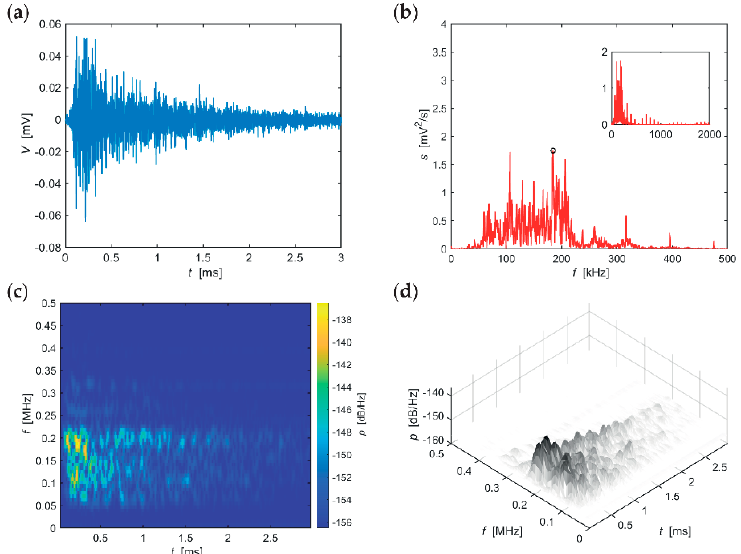
Figure 6. Visualisation of the recorded AE signal during 50–75 F-T cycles from specimens CS100: ( a ) time course of the amplitude, ( b ) frequency spectrum, ( c ) spectrogram STFT-2D image, ( d ) spectrogram STFT-3D image.